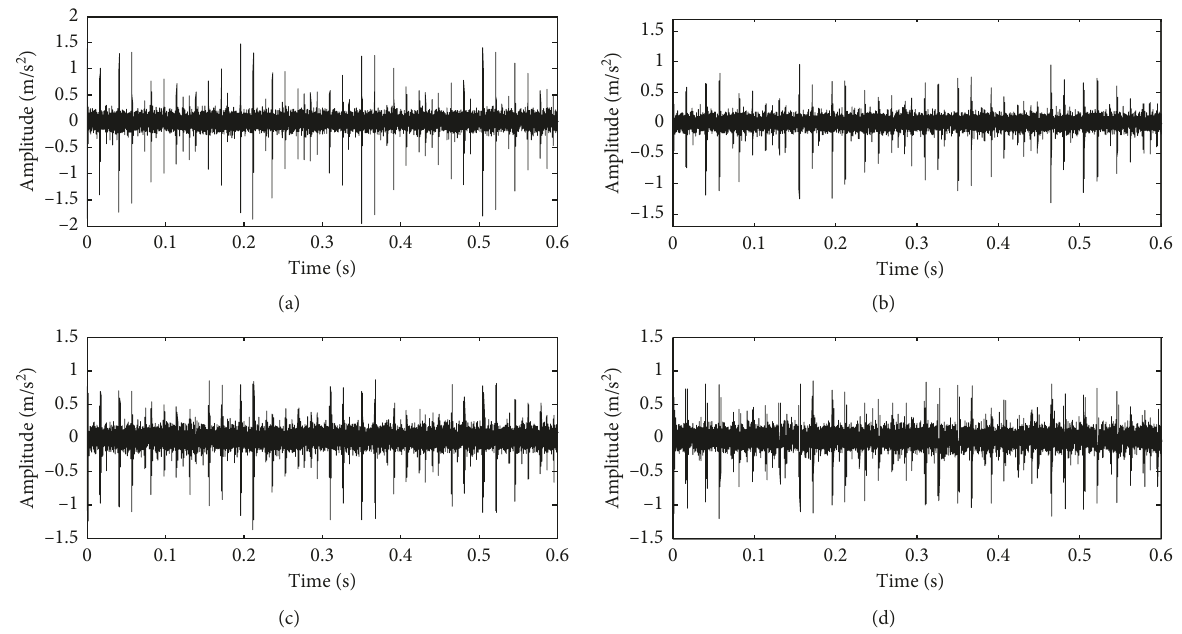
Figure 2: Simulation vibration signal of bearing inner race with different fault sizes. (a) Fault diameter: 0.5 mm. (b) Fault diameter: 2mm. (c) Fault diameter: 3.5mm. (d) Fault diameter: 5mm.